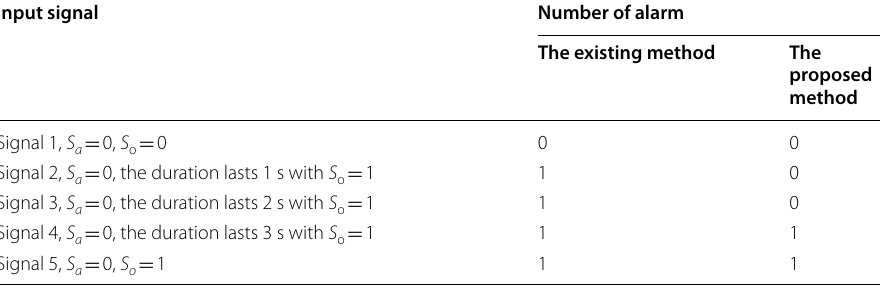
Table 2 Comparison of alarm method with the five types of presetting signals Input signal Number of alarm